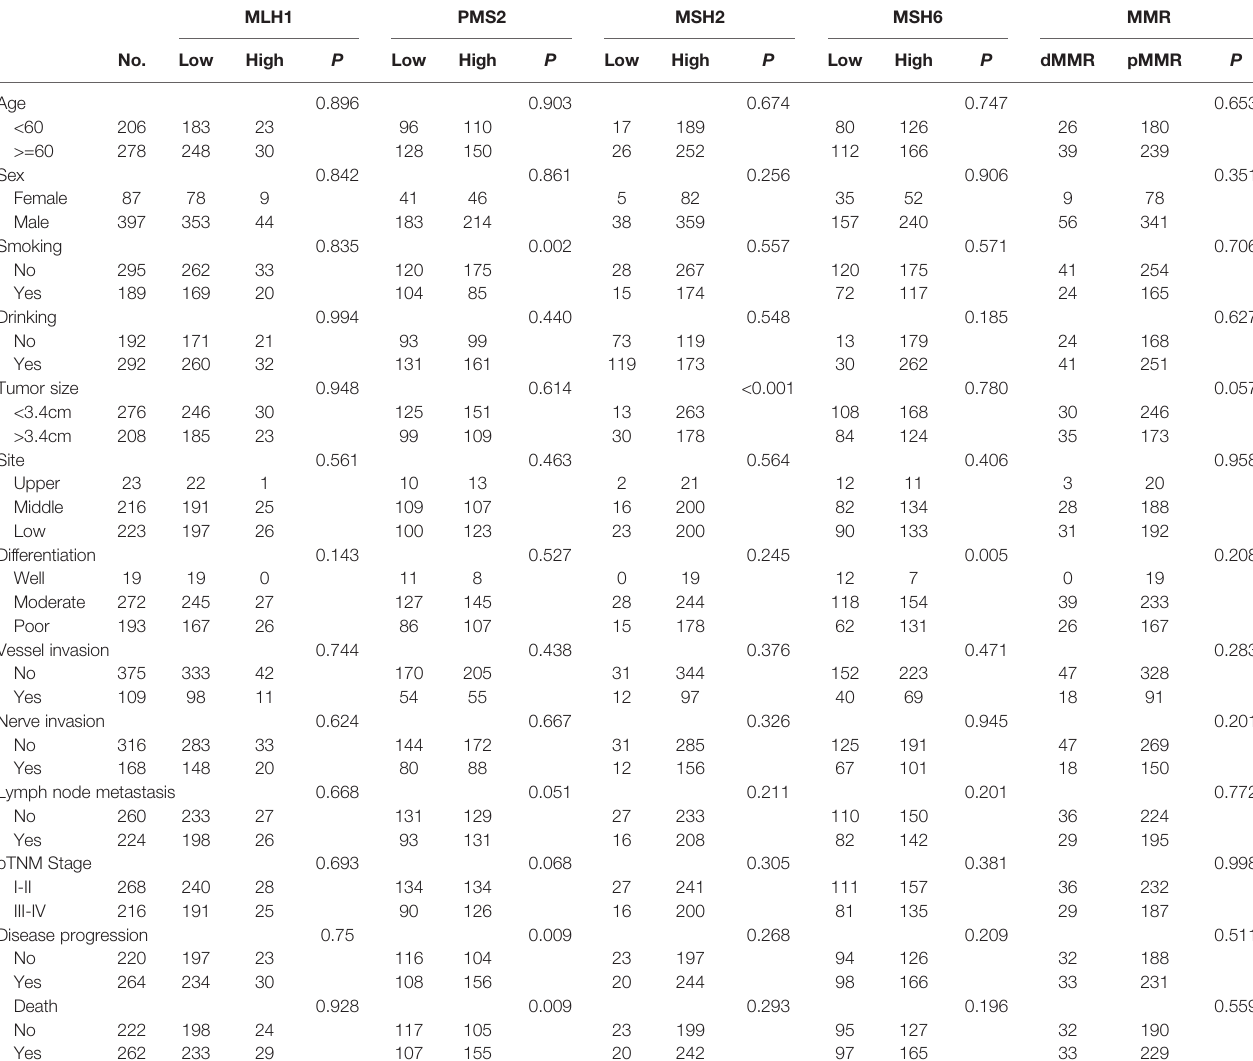
TABLE 1 | Association between MMR expression and clinicopathological features of ESCC patients.